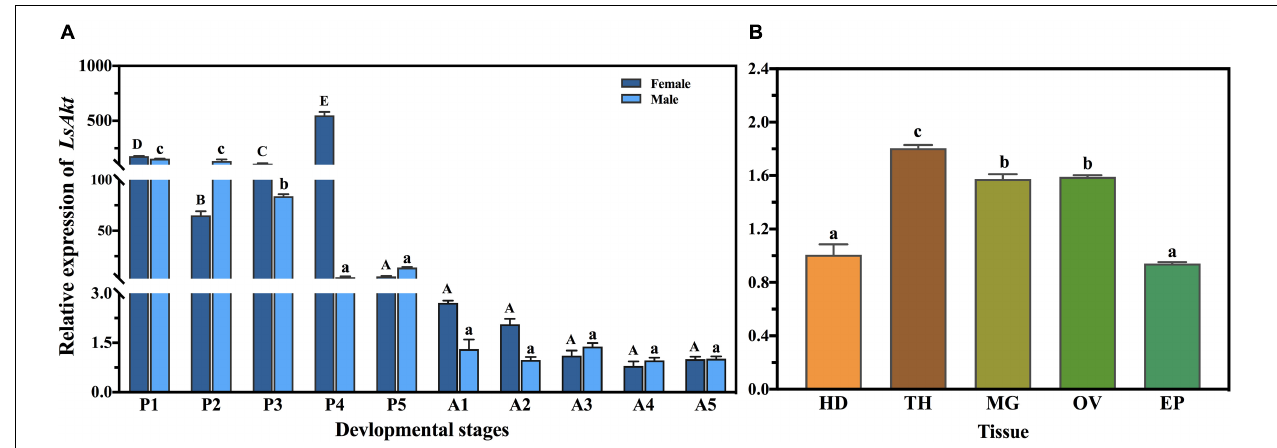
FIGURE 2 | Developmental and tissue-specific expression patterns of LsAkt . (A) Temporal expression of LsAkt at different developmental stages. P1–P5, days 1–5 of the pupae; A1–5, days 1–5 of the adults. (B) Tissue distribution of LsAkt transcript in day-5 adults. HD, head; TH, thorax; MG, midgut; OV, ovary; EP, epidermis. Different uppercase letters above bars indicate significant differences of female insects, lowercase letters indicate significant differences of male insects or tissues based on one-way ANOVA followed by a least significant difference test ( P < 0.05).